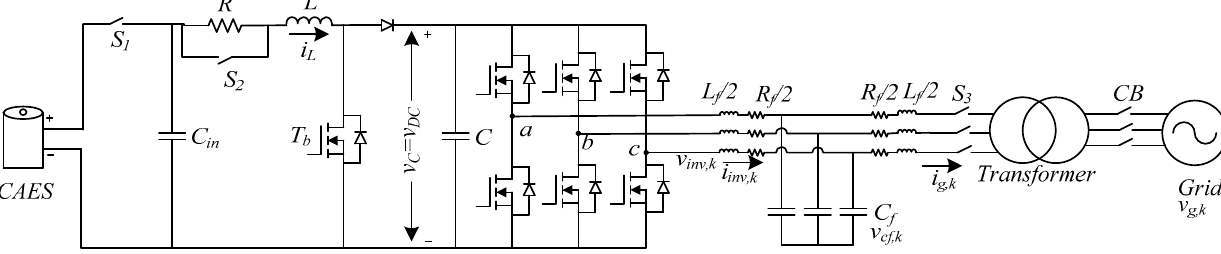
Figure 2. Block diagram of the system under study.